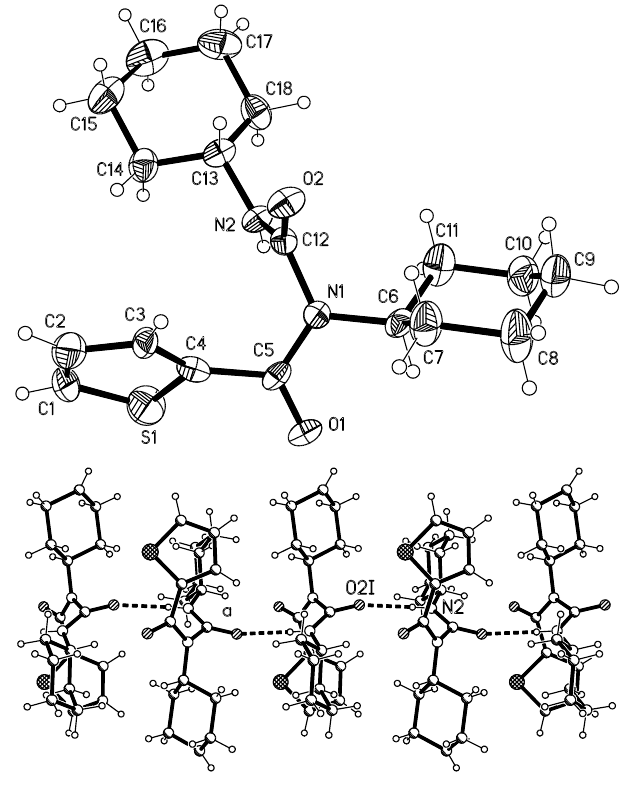
Table 1. Data collection and